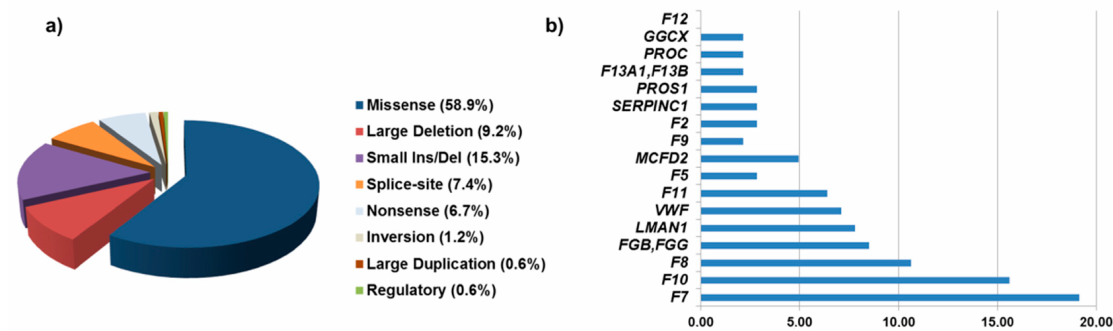
Figure 1. Genetic variants in patients with FMCFD. ( a ) Profile of genetic variants and ( b ) the prevalence of single-factor deficiencies in our